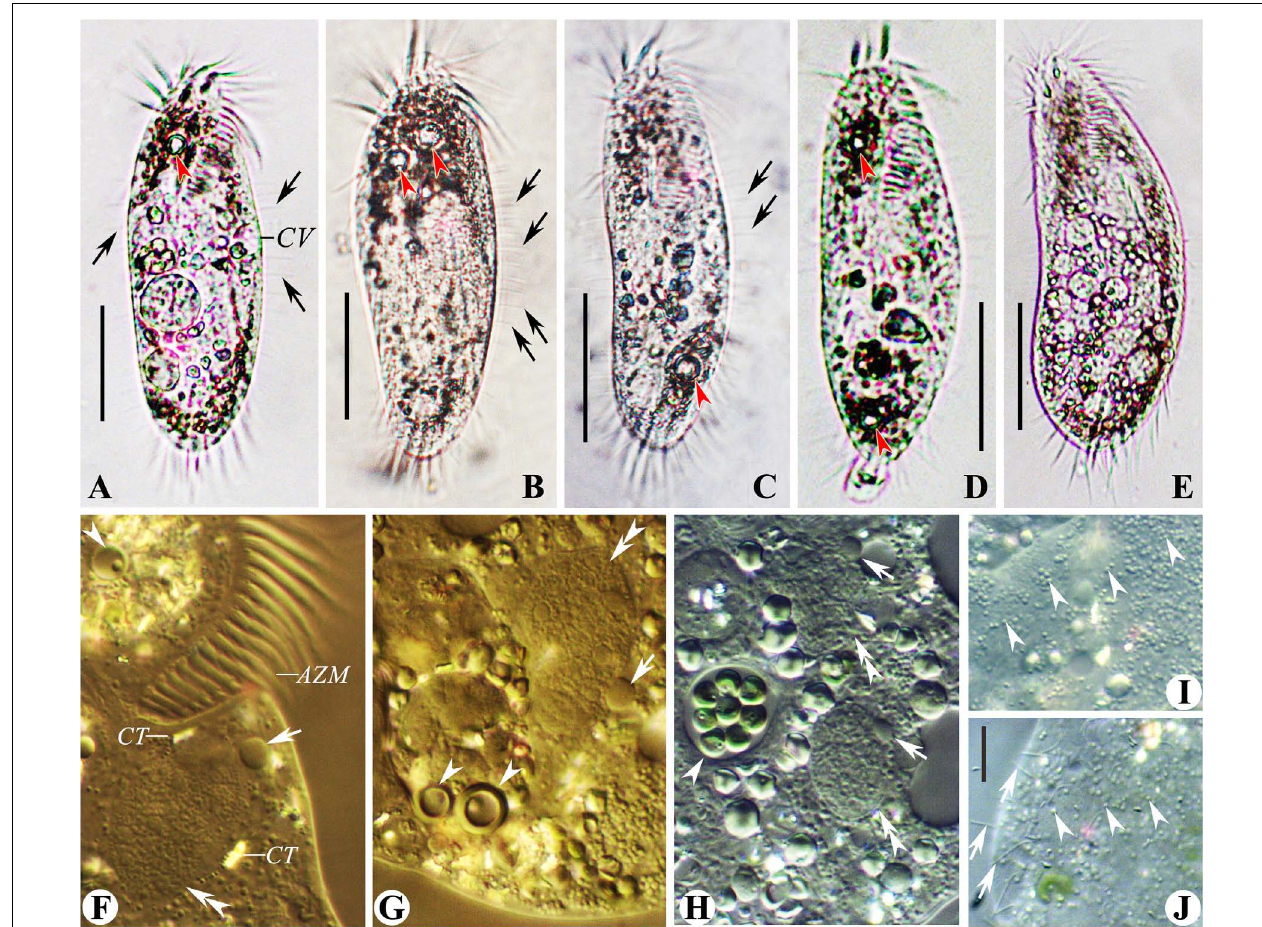
FIGURE 3 | (A–J) Morphology of the Zhuhai population of Oxytricha lithofera from life ( A–E , bright field; F–J , differential interference contrast). (A–E) Ventral views of representative individuals, showing body shape, flexibility, contractile vacuole, lithosomes (arrowheads), and the long dorsal bristles (arrows). (F,G) Anterior (F) and posterior (G) part of the same specimen, showing three lithosomes (arrowheads), two macronuclear nodules (double arrowheads), two large-sized micronuclei (arrows), and crystals. (H) Ventral view, showing macronuclear nodules (double arrowheads), micronuclei (arrows), food vacuole (arrowhead), and inclusions. (I,J) Mitochondria-like cortical granules (arrowheads) on ventral (I) and dorsal (J) side; arrows in (J) indicate the long dorsal bristles. AZM, adoral zone of membranelles; CT, crystals; CV, contractile vacuole. Scale bars = 30 µ m (A–E) and 10 µ m (J)